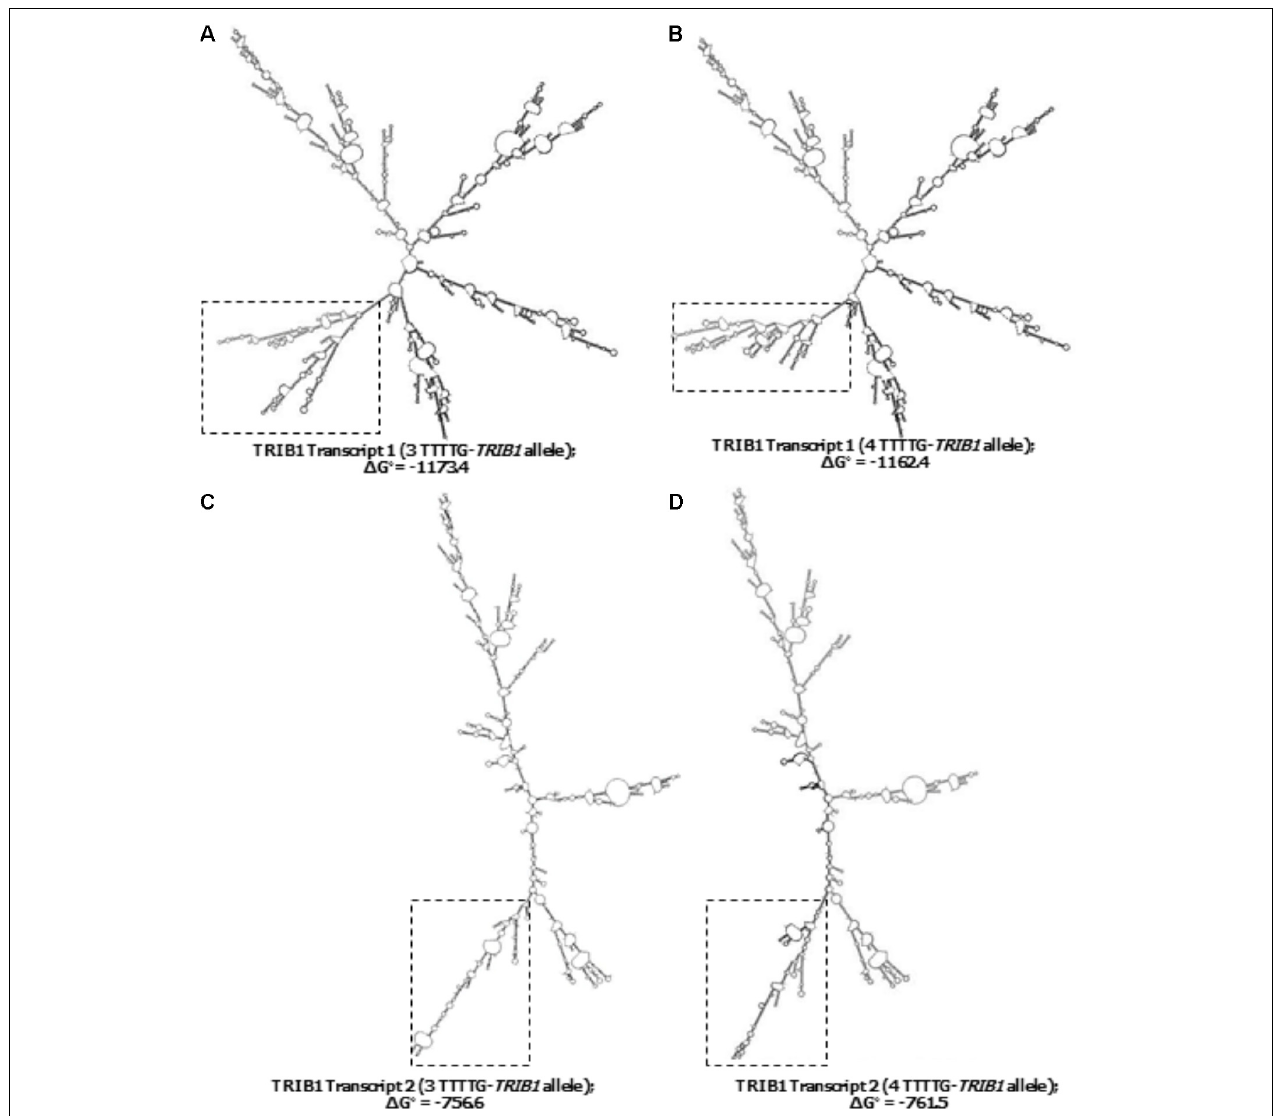
FIGURE 4 | Predicted secondary structures of the two TRIB1 mRNA transcripts. Showing two examples of the differences observed in the predicted TRIB1 mRNA structure of the TRIB1 transcript variant one with the three (A) and four (B) TTTTG- TRIB1 repeats alleles; and of the TRIB1 transcript variant two with the three (C) and four (D) TTTTG- TRIB1 repeats alleles. The dotted squares highlight the secondary structures differences in the final structure. Data obtained from mfold web server v.3